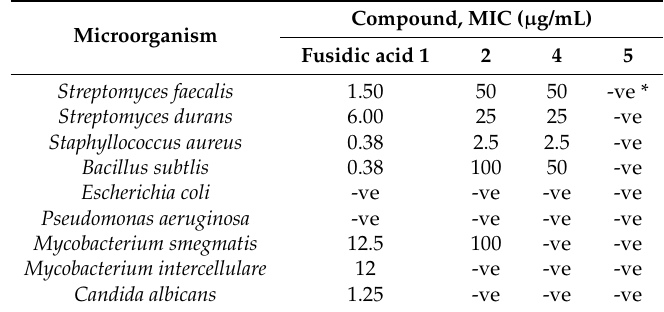
Table 3. Antimicrobial activity testing of fusidic acid and the isolated